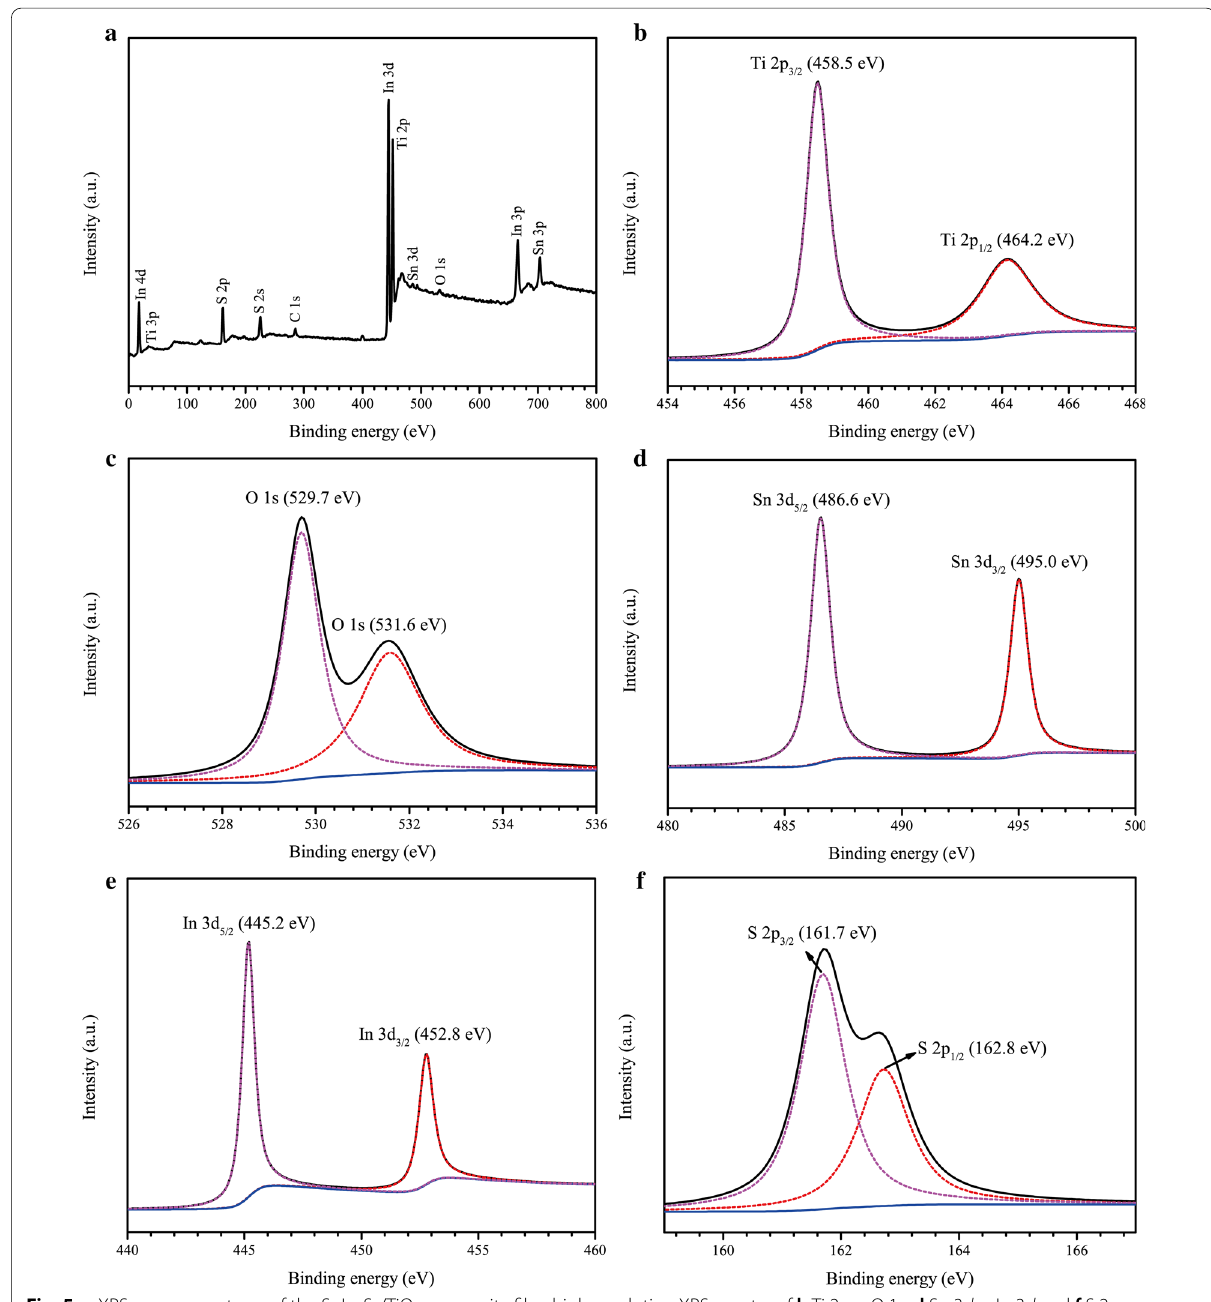
Fig. 5 a XPS survey spectrum of the SnIn 4 S 8 /TiO 2 composite film; high-resolution XPS spectra of b Ti 2 p , c O 1 s , d Sn 3 d , e In 3 d and f S 2